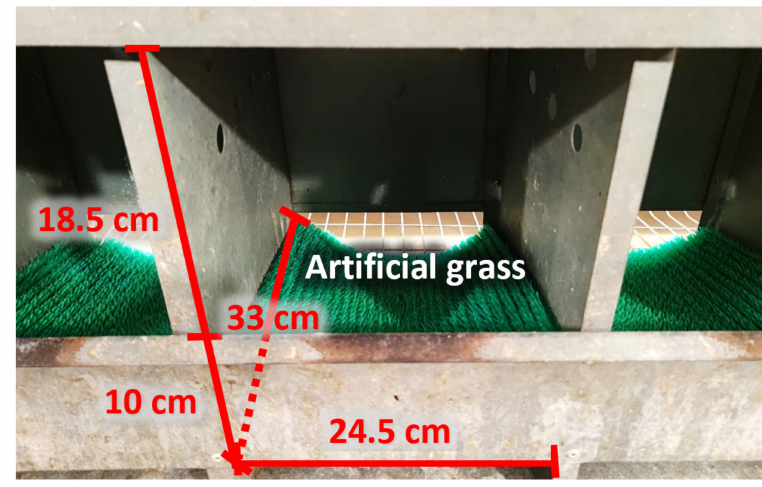
Figure 4. The design and dimensions of the nest with artificial